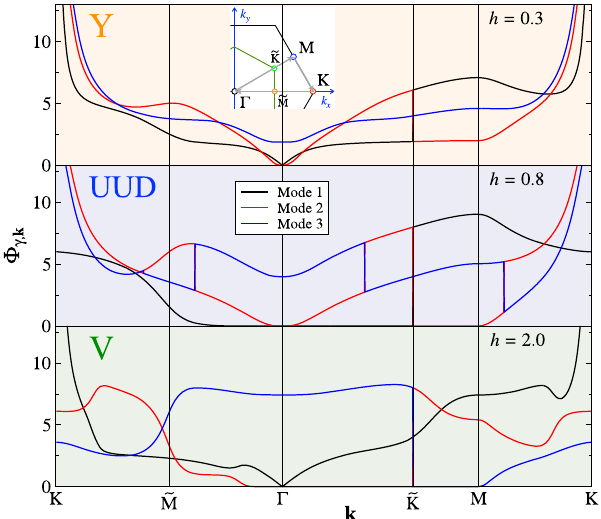
FIG. 7. Combinations Φ γ in Eq. (39) of the matrix elements in ; k Eq. (36) for several representative field values along a represen- tative cut K Γ MK through the full BZ (see Fig. 5): Y